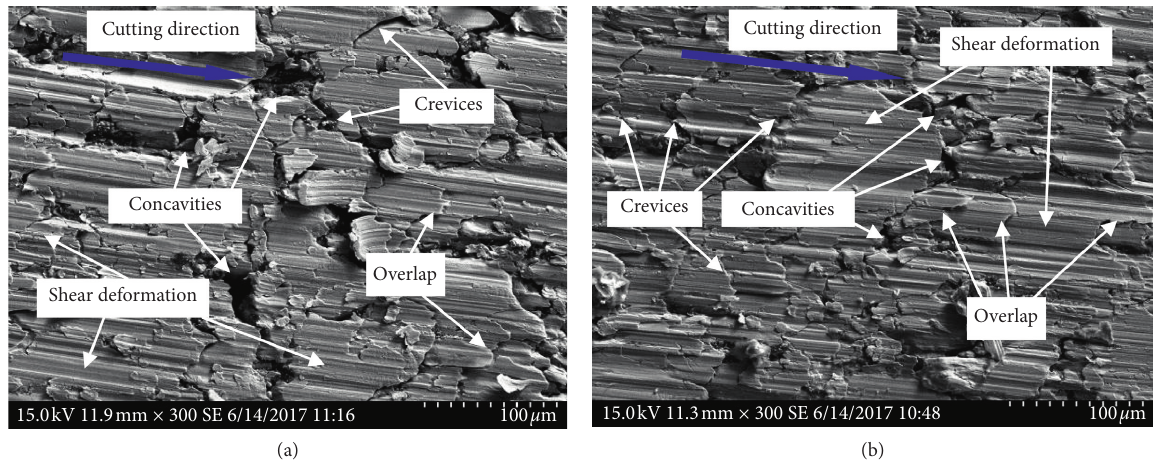
Figure 4: Machined surface morphology corresponding to thicknesses of (a) 0.1mm and (b)